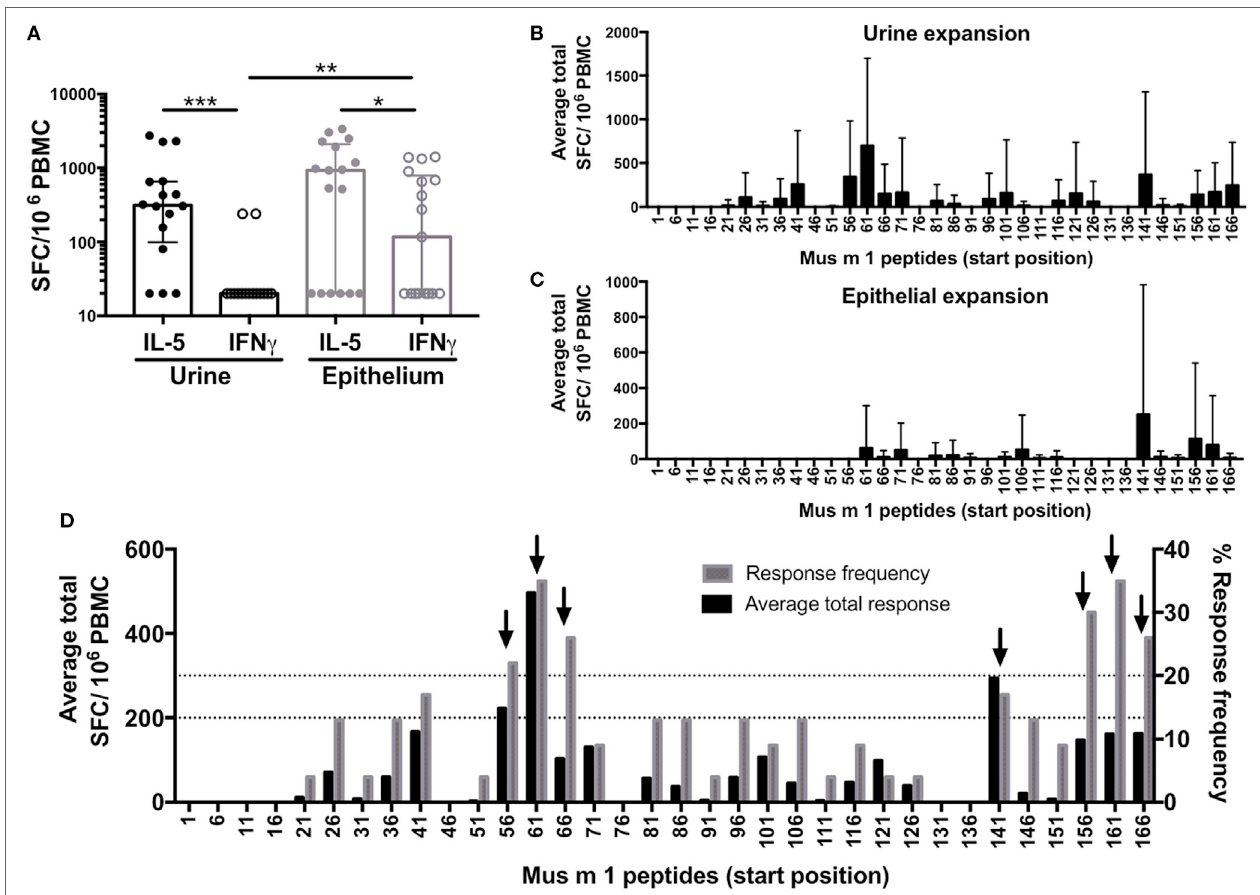
FigUre 1 | Allergic T cell responses to mouse urine and epithelial extract and the major allergen Mus m 1. Cytokine production was measured by ELISPOT following in vitro restimulation with (a) urine or epithelial extract; or overlapping 15-mer peptides spanning Mus m 1 after in vitro culture with (b) urine or (c) epithelial extract. Error bars indicate SDs. (D) Data from Mus m 1-derived peptide responses after urine and epithelial expansion were combined to identify immunodominant peptides [frequency ≥ 20%; magnitude ≥ 200 spot-forming cells (SFC)], indicated by black arrows. Responses below detection threshold were set to 20 SFC. Statistical analysis was performed by Wilcoxon signed rank test (paired), one-tailed comparison for IL-5 vs. IFN γ , and Mann–Whitney test (unpaired), two-tailed comparison for IFN γ vs. IFN γ . * p < 0.05, ** p < 0.01, and *** p < 0.001.